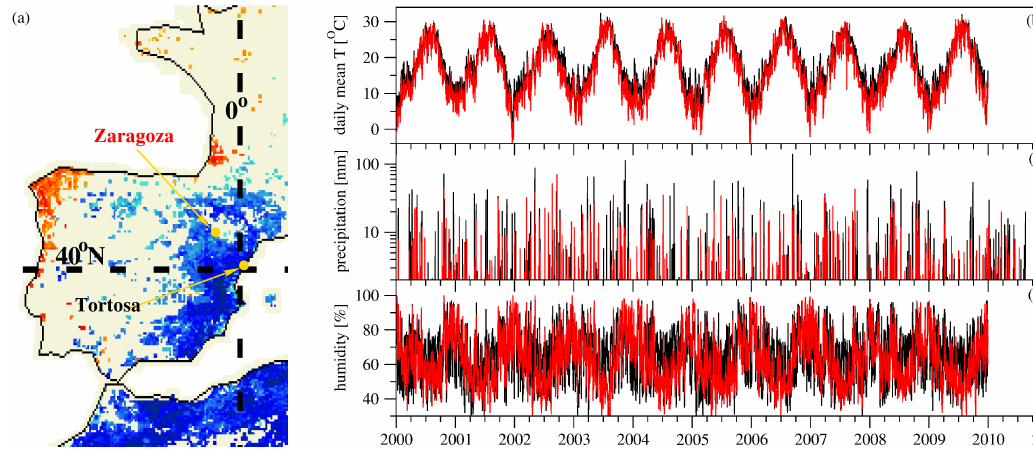
Figure 8. (a) Locations of two weather stations embedded in an apparently wetting region in eastern Spain: Tortosa (40.82 ◦ N, 0.48 ◦ E) and Zaragoza (41.65 ◦ N, 1.00 ◦ W). (b) Daily mean temperature, (c) daily precipitation (note the logarithmic vertical scale), and (d) daily relative humidity for the two stations (black: Tortosa, red: Zaragoza). Data from Klein Tank et al. (2002).